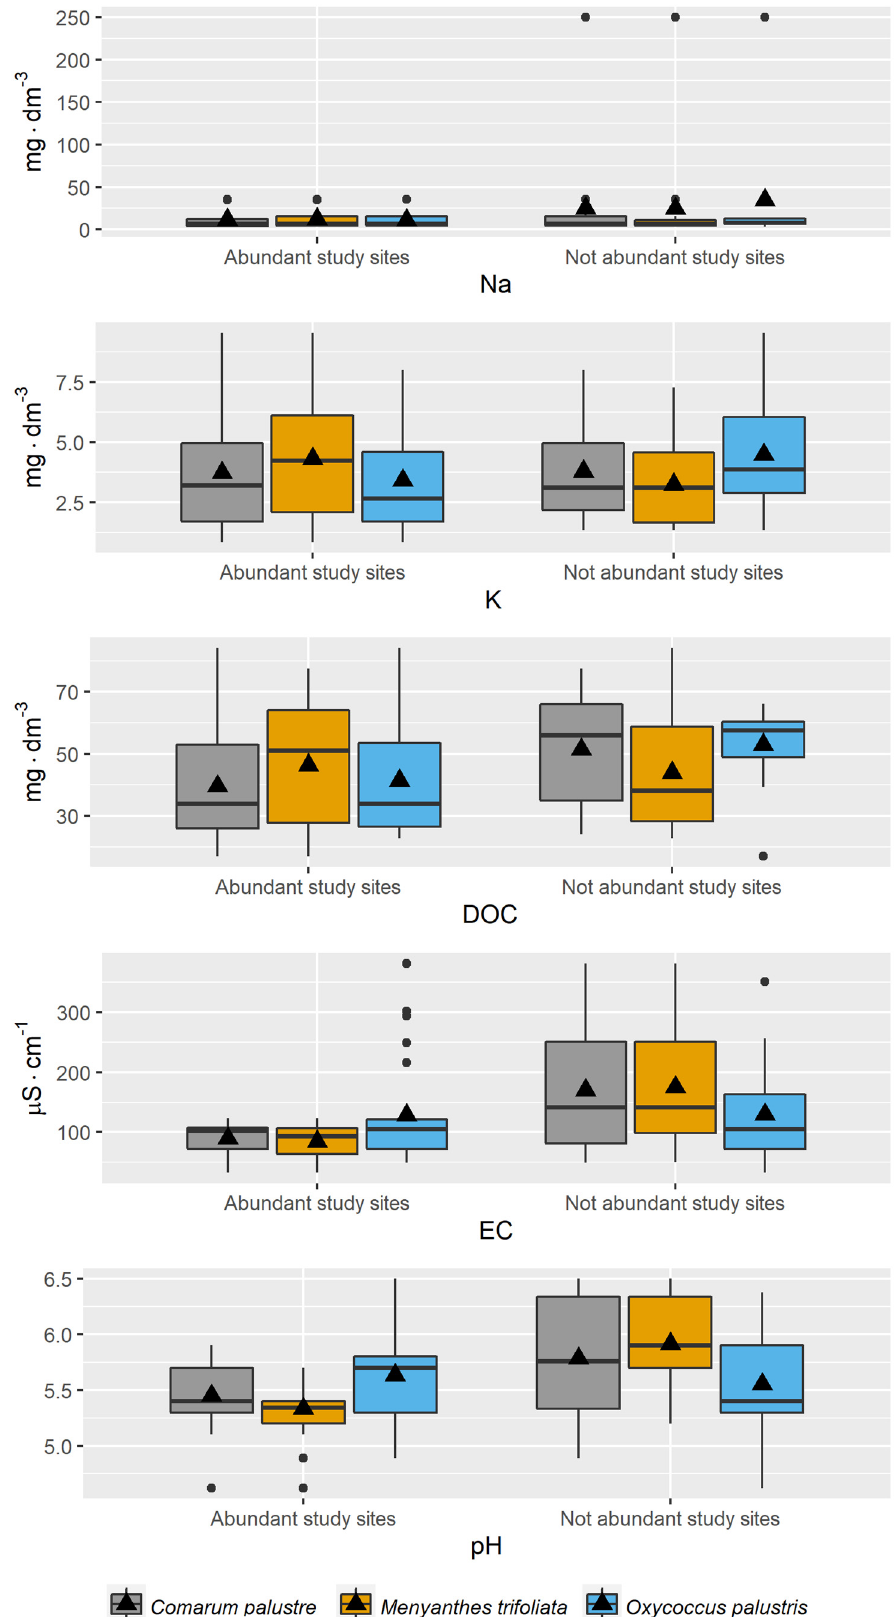
Figure 5. Distribution of Na, K, DOC, EC, and pH values in piezometric groundwater at the study sites for the study species in 2011–2013 (criterion of abundance in habitats).